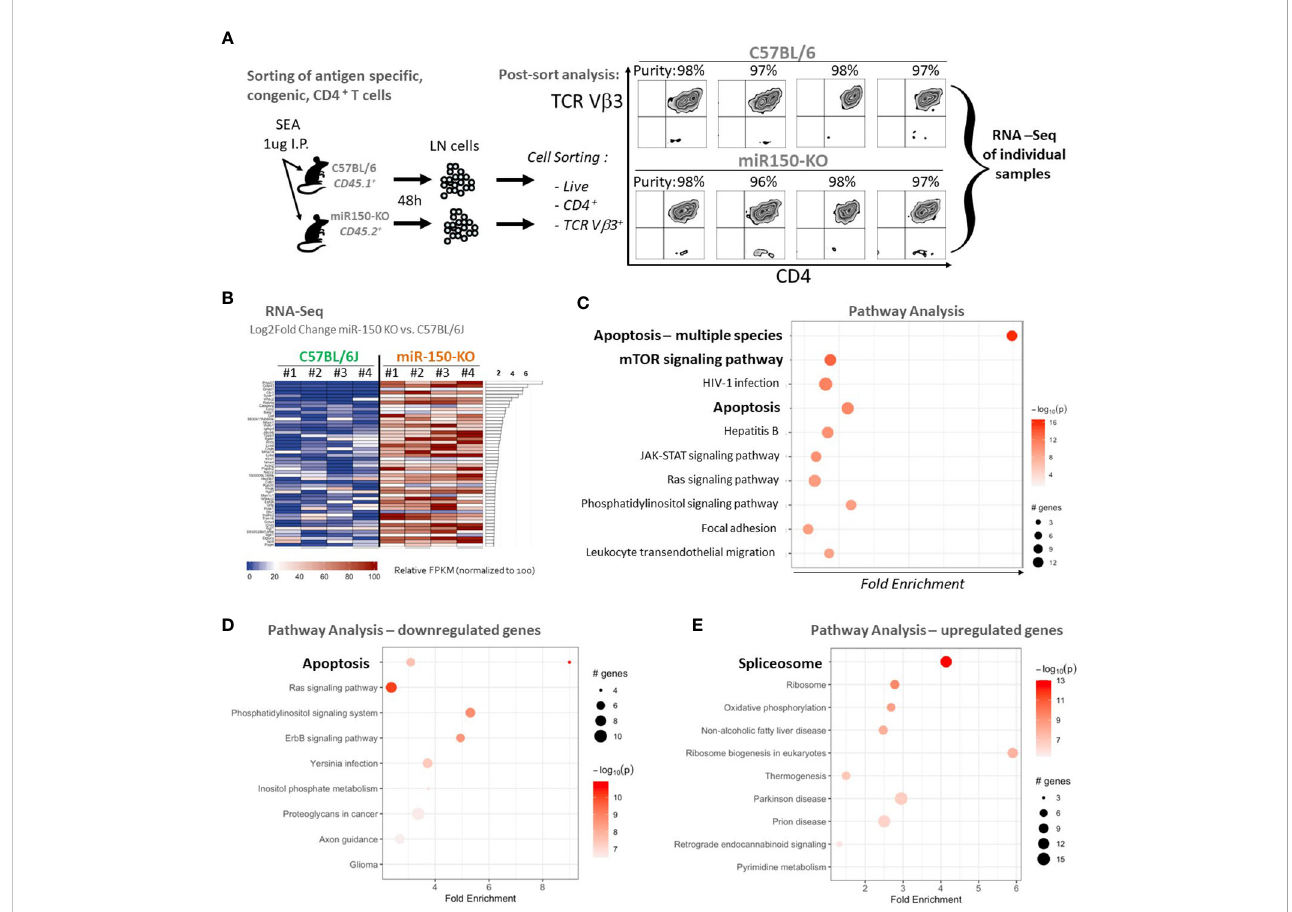
FIGURE 4 Apoptotic pathways are under regulation of miR-150 in antigen-speci fi c CD4 + T cells. (A) Lymph node (LN) cells from miR-150-KO and WT mice were stained 48 h post-SEA challenge with lineage-speci fi c antibodies, and sorted to high purity. (B) Pathway analysis with Path fi ndR was conducted on 674 differentially expressed genes using both upregulated (390 genes) and downregulated (284 genes) genes fi ltered from DESeq using a p-value differential cutoff of p-value<.05. Relative FPKM levels of the top 50 (of 674 genes) ranked by log 2 fold change between C57BL/6J and miR-150-KO sorted CD4 + Vb3 + cells (FDR<.05) are shown, n=4/group. (C) Pathway analysis of 674 genes identi fi ed in 4B ranked by log2fold change between C57BL/6J and miR- 150-KO n=4 per group. (D) Pathway analysis of 284 genes found downregulated in miR150 KO vs WT CD4+ T cells by log2Fold Change with p-value <.05. n=4 per group. Two distinct but overlapping KEGG pathways (mmu04210 and mmu04215) for Apoptosis were identi fi ed by Path fi ndR and as such, appear as two circles on the same line. (E) Pathway analysis of 390 genes found upregulated in miR150 KO vs WT CD4+ T cells by log2Fold Change with p-value <.05. n=4 per group. Canonical apoptotic regulators Bax, Bid, Cycs were grouped under alternative disease pathways (Non-alcoholic fatty liver disease and Prion